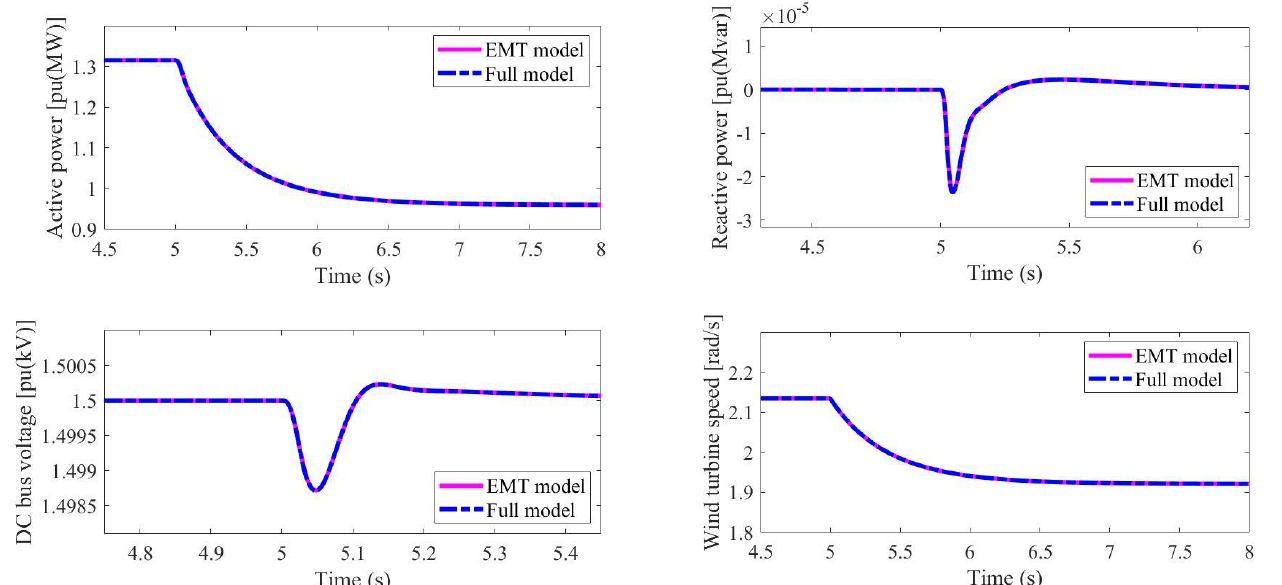
Figure 4. Variable wind speed: full model vs. EMT model.